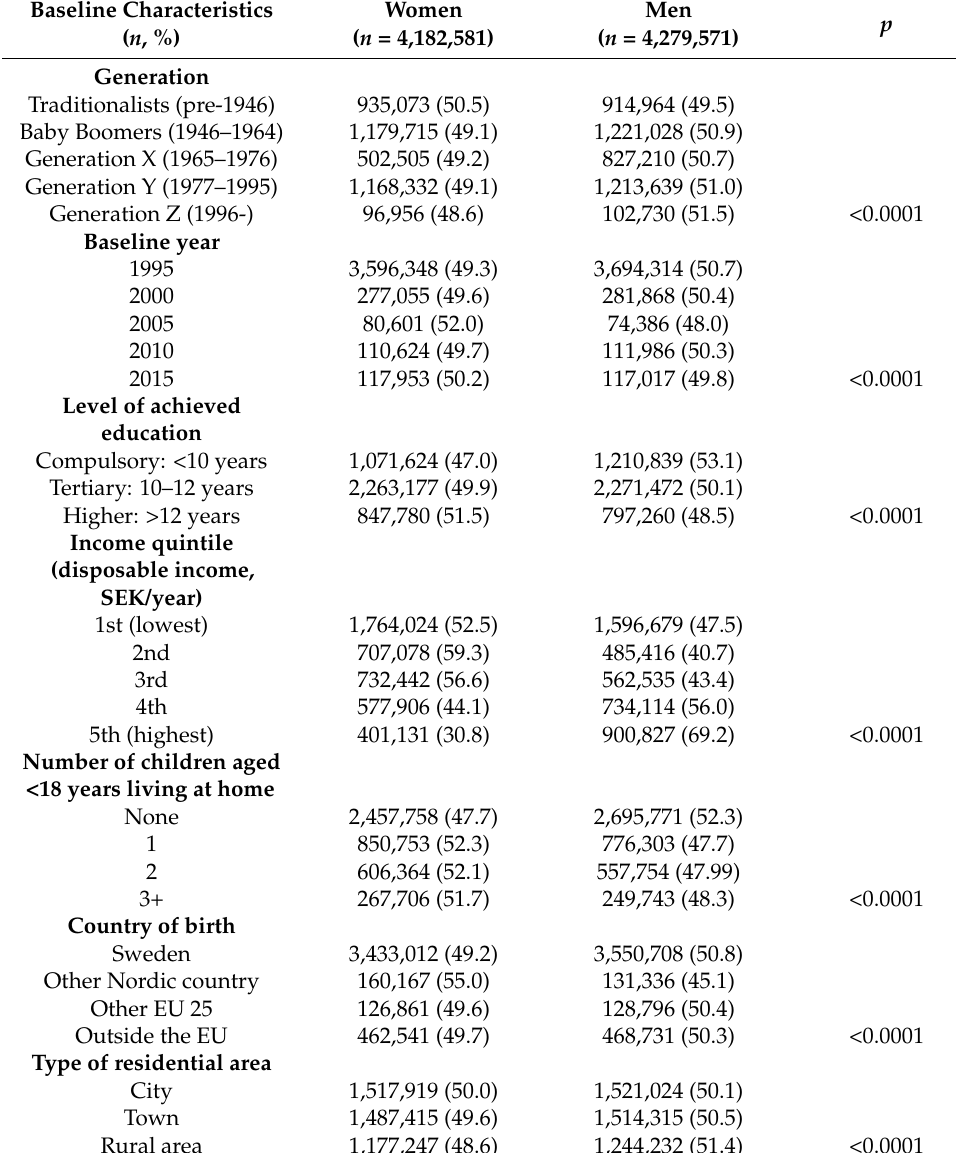
Table 1. Sociodemographic characteristics of the study population ( n =